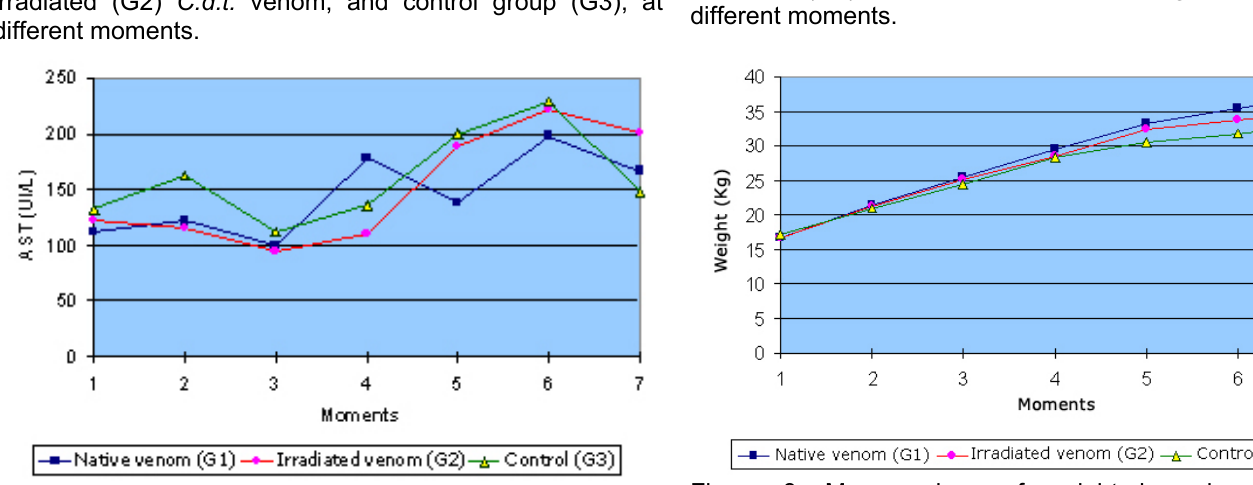
Figure 8: Mean values of weight in ovine groups Figure 7: Mean values of aspartate aminotransferase (AST) inoculated with natural (G1) and 60 Co-irradiated (G2) C.d.t. dosage (UI/l) in ovine groups inoculated with natural (G1) venom, and control group (G3), at different moments. and 60 Co-irradiated (G2) C.d.t. venom, and control group (G3), at different moments. Moments: 1= day 1; 2 = day 14; 3 = day 28; 4 = day 42; 5 = day 56; 6 = day 70; 7 = day